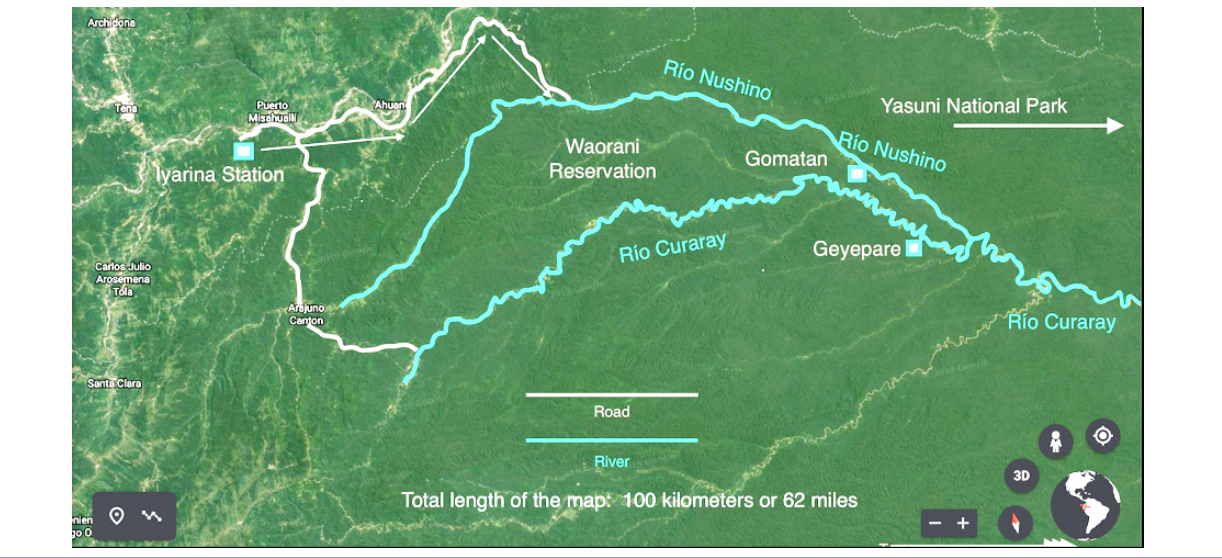
Fig. 1 . Location of the Andes and Amazon Field School main station (Iyarina), and the two Waorani communities where interviews were conducted (Gomatan and Geyepade). Basemap source: Landsat / Copernicus, accessed through Google